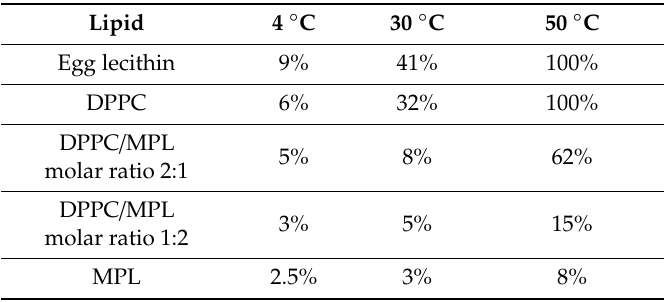
Table 12. Carboxyfluorescein release (% increase of